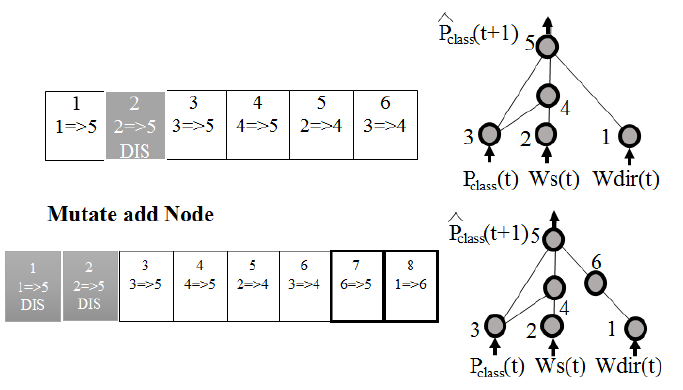
Figure 8. Mutation by appending a node, where Node 6 is inserted between Node 1 and Node